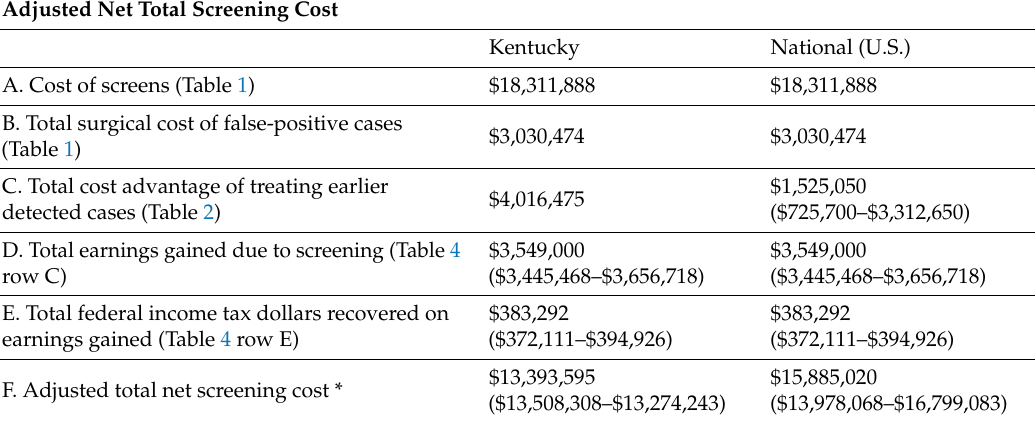
Table 6. Summary of the total net cost of the Kentucky screening program from 1987 to 2019 when accounting for the cost of screens, total surgical cost of false-positive cases, cost advantage of treating more early-stage disease, lost earnings gained and federal tax dollars recovered by women saved due to